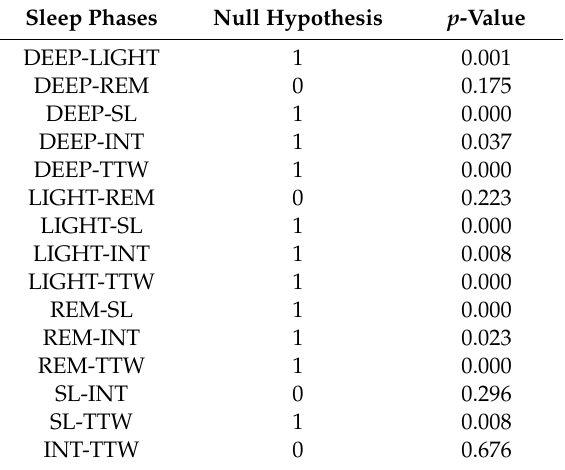
Table 3. Statistical results from the Wilcoxon